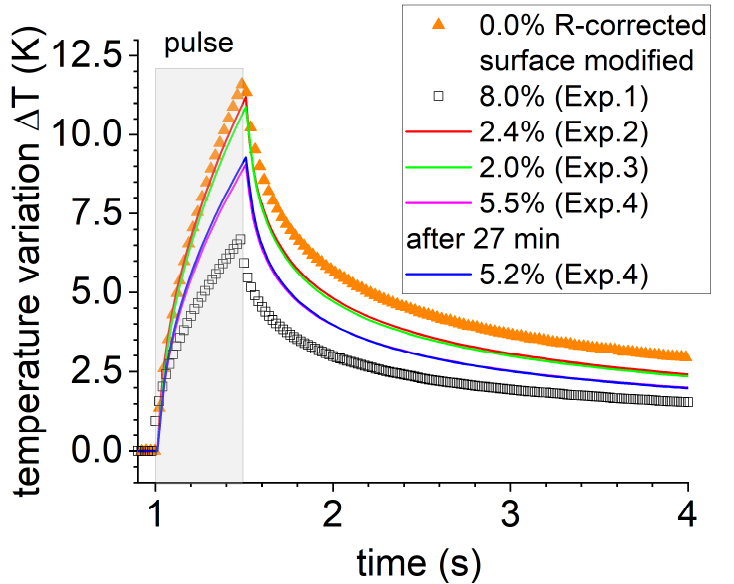
Figure 17. Surface temperature transients recorded in the type 1 sample (cut side) in different trials with different moisture contents. The 0% curve is shifted to higher values to correct for the increased reflection on the surface; the other curves are raw data without any correction. Temperature transients from the formwork side of the type 1 and type 3 samples are displayed in Figures 19 and 20, respectively, showing the same effects in